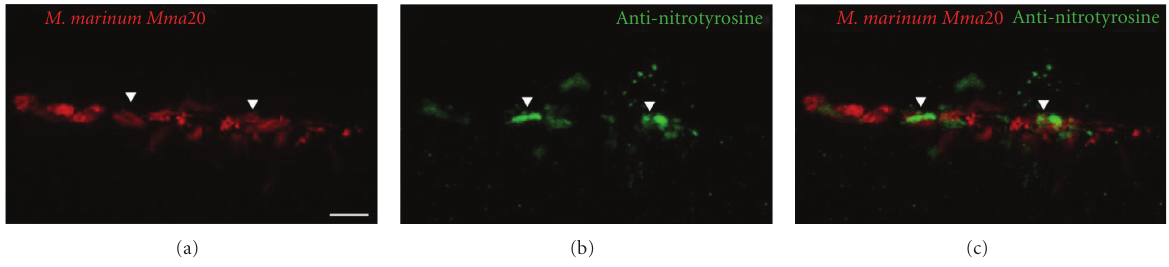
Figure 3: In situ detection of reactive nitrogen species. Wild-type zebrafish embryos (Albino; 28 hpf) were injected into the caudal vein with 200 colony-forming units (CFU) of M . marinum Mma20 expressing a pMST3::mCherry vector. Confocal images were taken of a tail region of the developing larva at 3 days after infection (3dpi), a point at which the M . marinum infection (a) has been established. Embryos were fixed in 4% paraformaldehyde at 3 dpi, and immunohistochemistry was performed, using an antinitrotyrosine antibody that detects tissue nitration (b) [21]. Colocalization (c) between bacteria and extensive tissue nitration can be observed at this time point. Scale bar: 10 μ